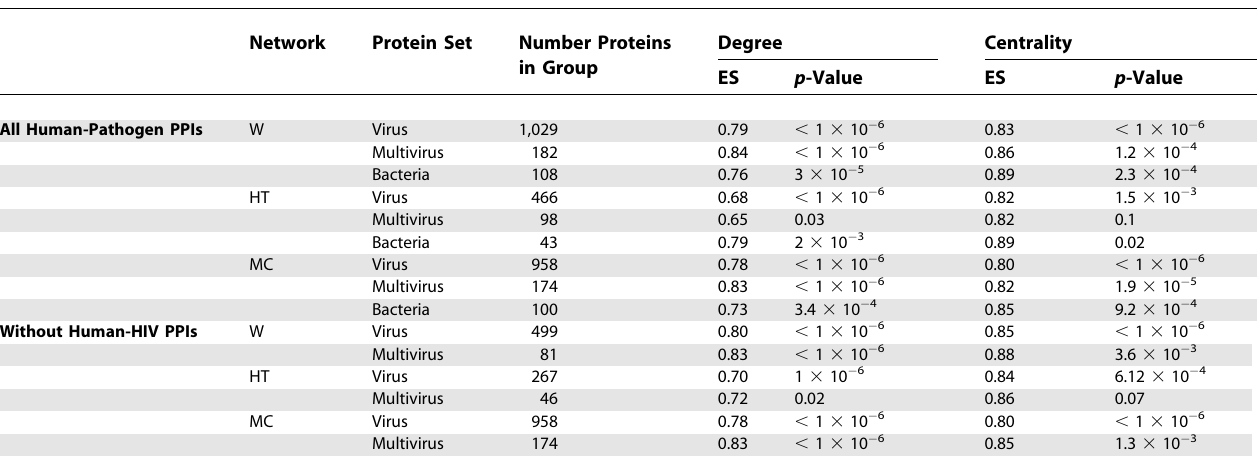
Network Protein